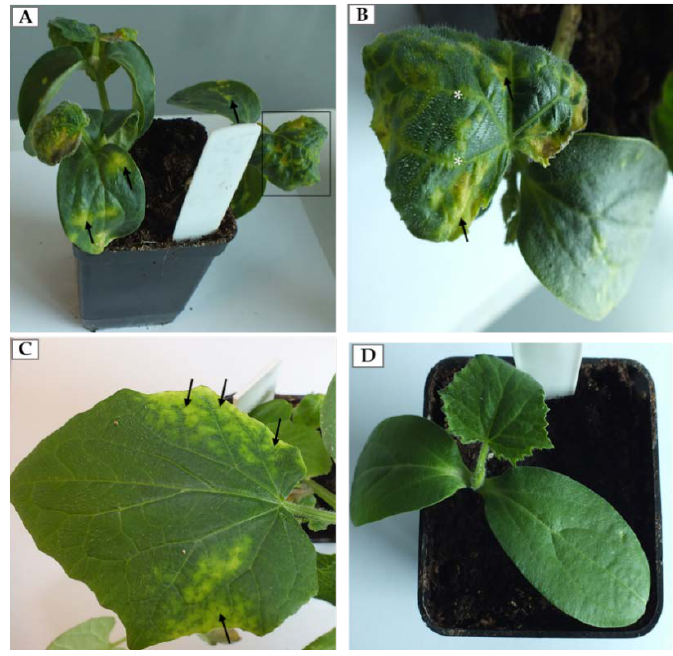
Figure 1. Morphological alternations of infection caused by Prune dwarf virus ( PDV) on cucumber. ( A ) Chlorotic spots (arrow) on the cotyledons and leaves of cucumber infected by PDV (14 dpi). The black frame area is enlarged in ( B ); ( B ) Enlarged deformed leaf with chlorotic spots (arrow) and yellowing veins (*); ( C ) Yellowing of leaf blades along the edges (arrow) at 14 dpi; ( D ) Mock-inoculated cucumber plants without symptoms (14 dpi).